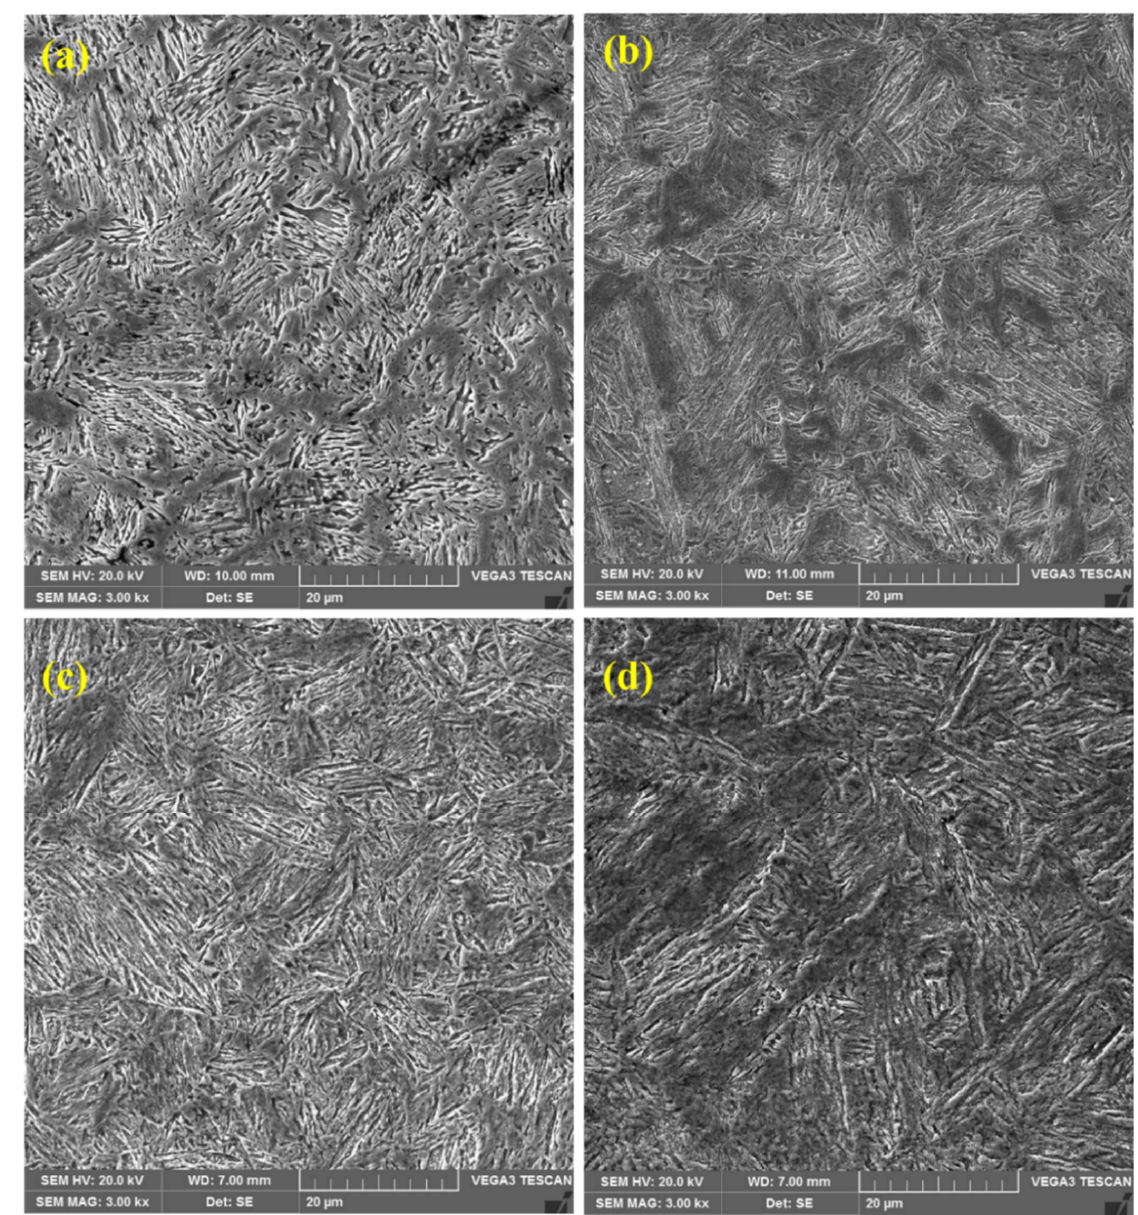
Figure 2. SEM micrographs of ballistic steel samples: ( a ) LT-1; ( b ) LT-2; ( c ) HT-1; ( d ) HT-2.